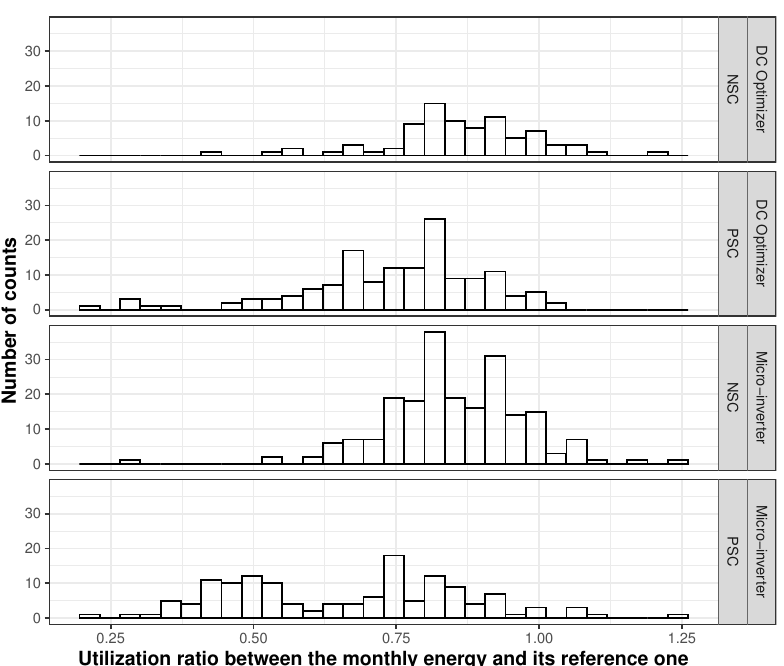
Figure 4. The distribution plots of the utilization ratio ( ur ) of the DC optimizer and microinverter PV systems in Table 1 under NSC and PSC. The ur can be larger than 1 since the actual number of sun hours for some months are higher than the estimated ones.